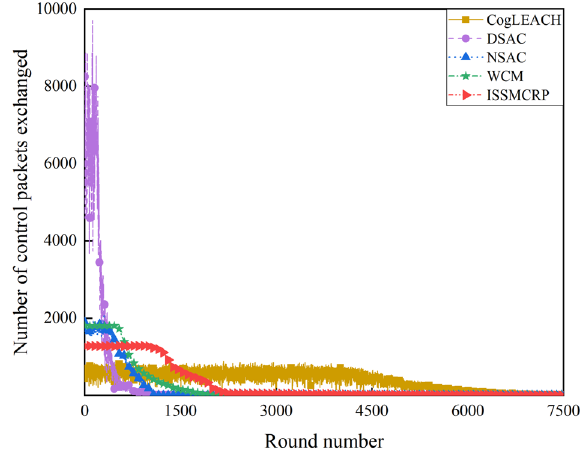
Figure 8. Comparison results of control overhead.